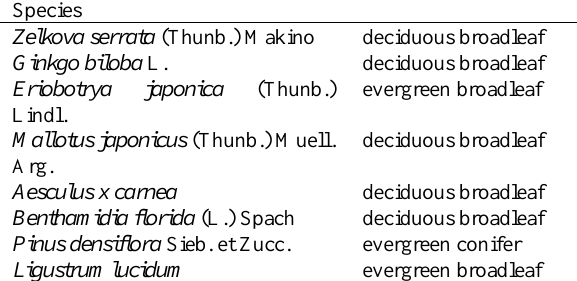
Figure 2. ROI (region of interest) of the target trees Table 2. Species of trees in image